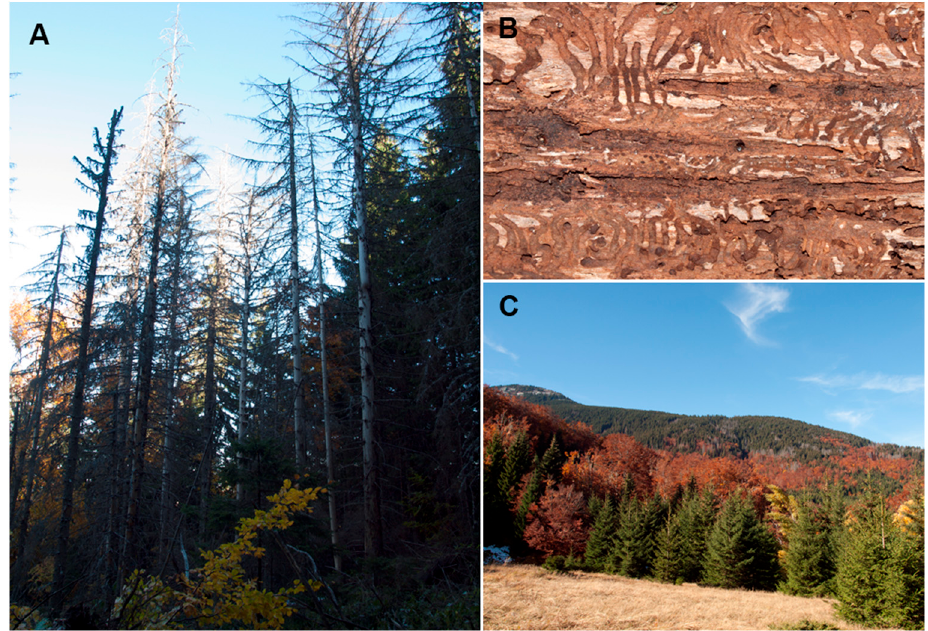
Figure 8. Damage caused by Ips typographus in the Chuprene Reserve: ( A )—dead spruce trees; ( B )—pest galleries under the bark; ( C )—migratory bark beetle spots.